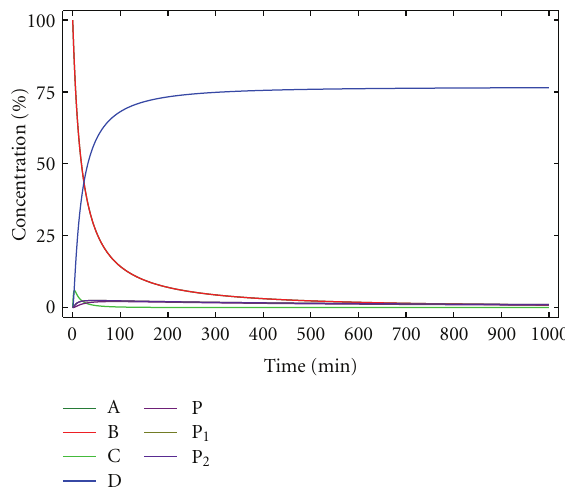
Figure 5: Concentration of the reactants, products, and reaction intermediates versus time for kinetic model 4. [A] 0 = [B] 0 = 0.005 M, k 1 = 10 M − 1 min − 1 , k 2 = 0.5 min − 1